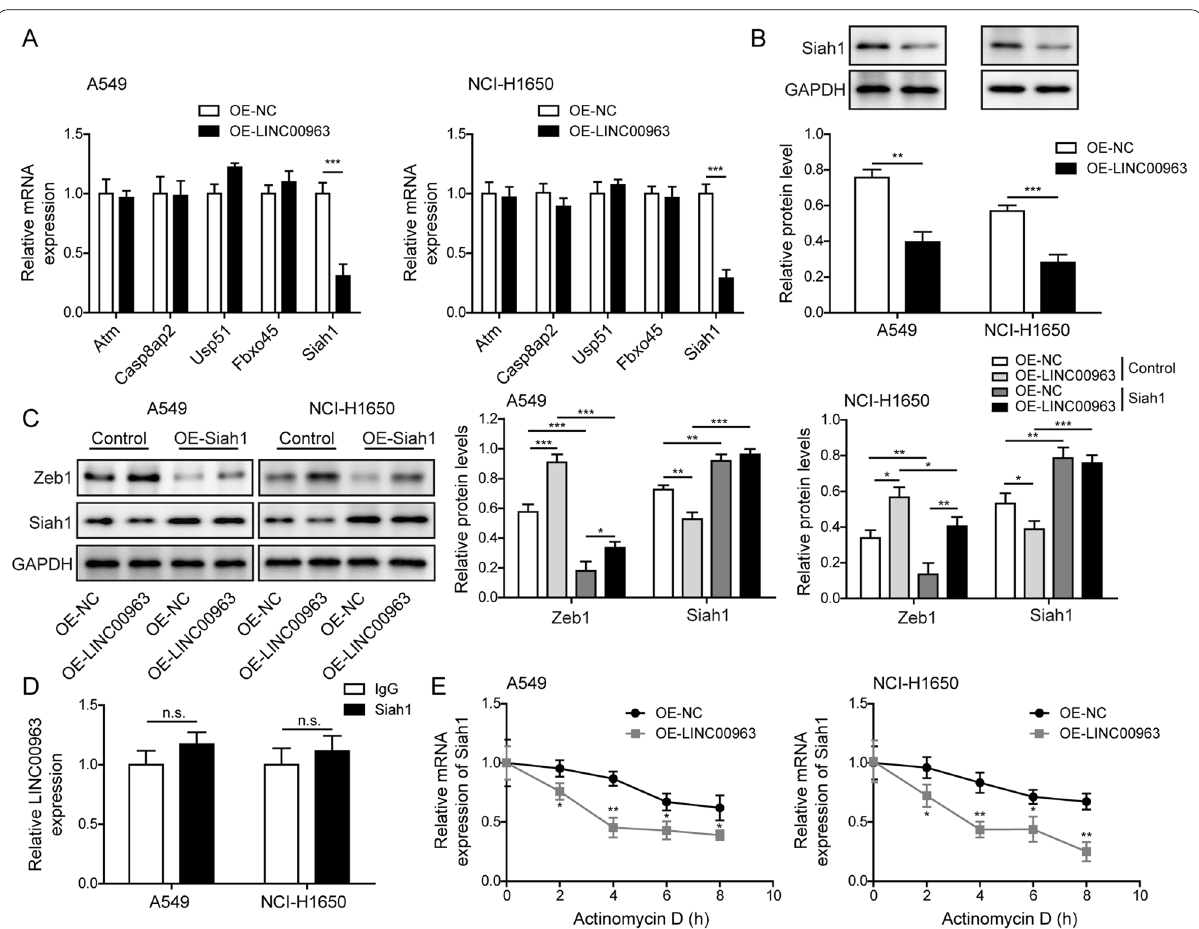
Fig. 6 LINC00963 triggered the degradation of Siah1 mRNA to induce up-regulation of Zeb1. A Expression levels of indicated E3 ubiquitin ligases were examined by RT-qPCR in LINC00963 overexpressed cells. B Siah1 protein level was examined by western blot in LINC00963 overexpressed cells. C Expression levels of Zeb1 and Siah1 were examined by western blot in indicated cells. D The potential interaction between LINC00963 and Siah1 was examined by RIP assay using anti-Siah1 and IgG (negative control) antibody. E The mRNA stability of Siah1 was examined by RT-qPCR after treating Actinomycin D for indicated time periods in LINC00963 overexpressed cells. n.s. , not significant, * P < 0.05, ** P < 0.01 and *** P <